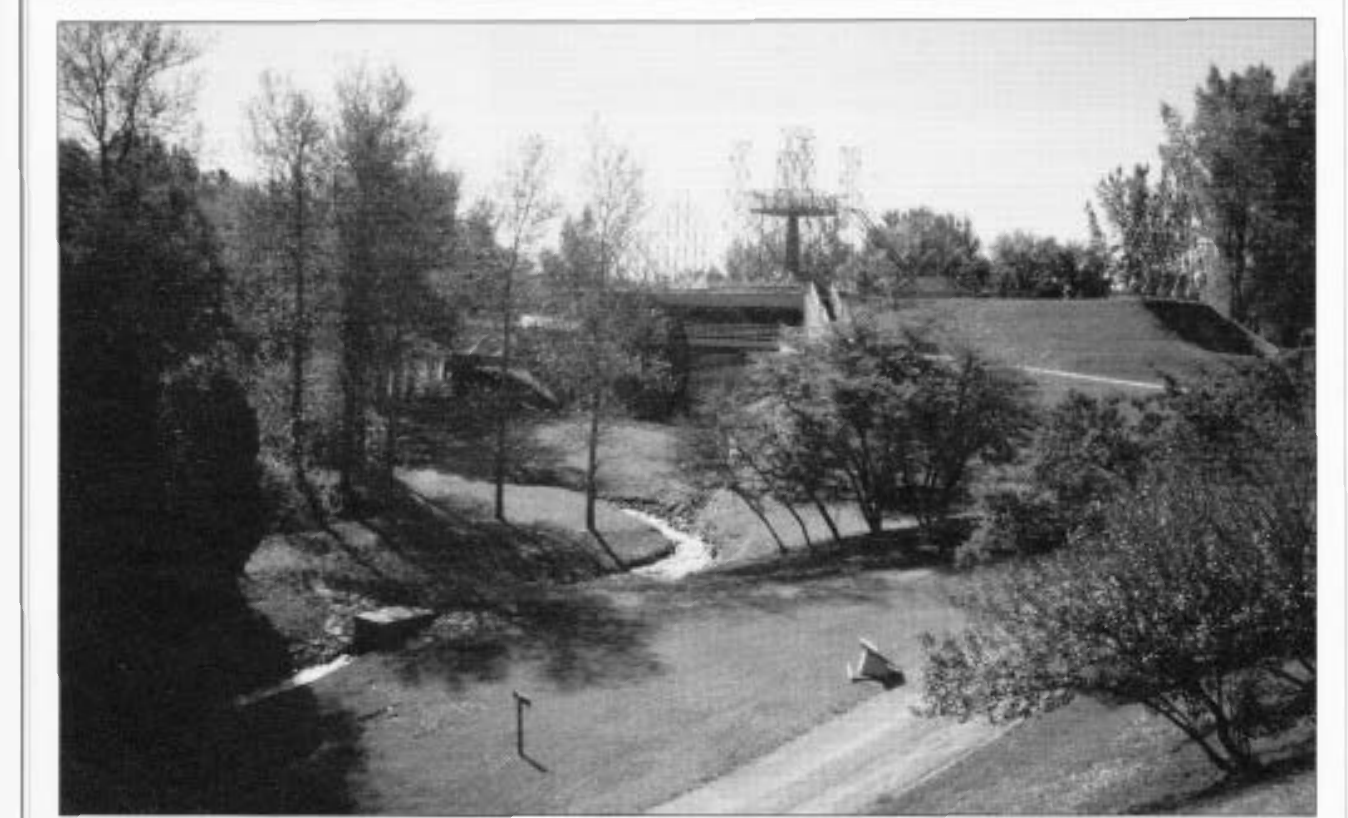
Figure 3 Forges du Saint Maurice, Quebec, the site of Canada's first ironworks: the outline of the original powerhouse is marked by the metal framework showing on the skyline; the narrow path at left has been excavated, and it formerly led workers to the mill (the reconstructed mill wheel is visible}; the wide and well graded walkway, with signs beside it, is an interpretation path for